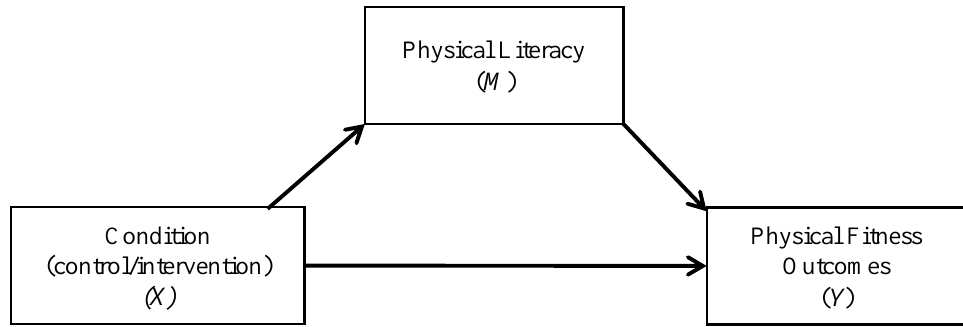
Figure 1 . Condition—moderate–vigorous physical activity single mediation model.